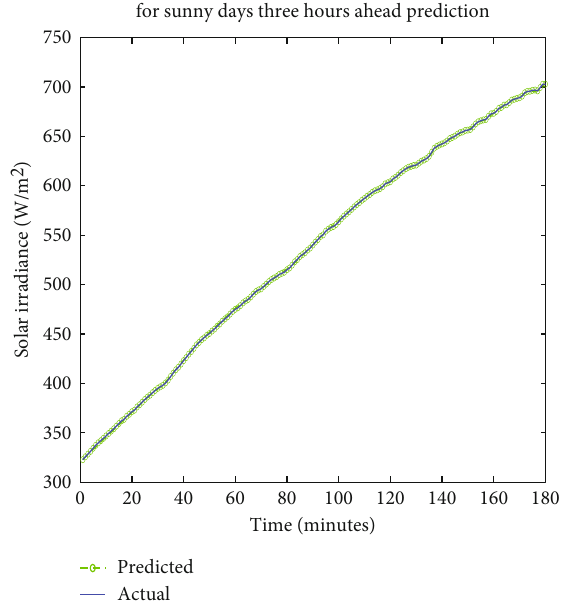
Figure 10: Comparison of predicted solar irradiance and actual solar irradiance for sunny day three-hour-ahead prediction.